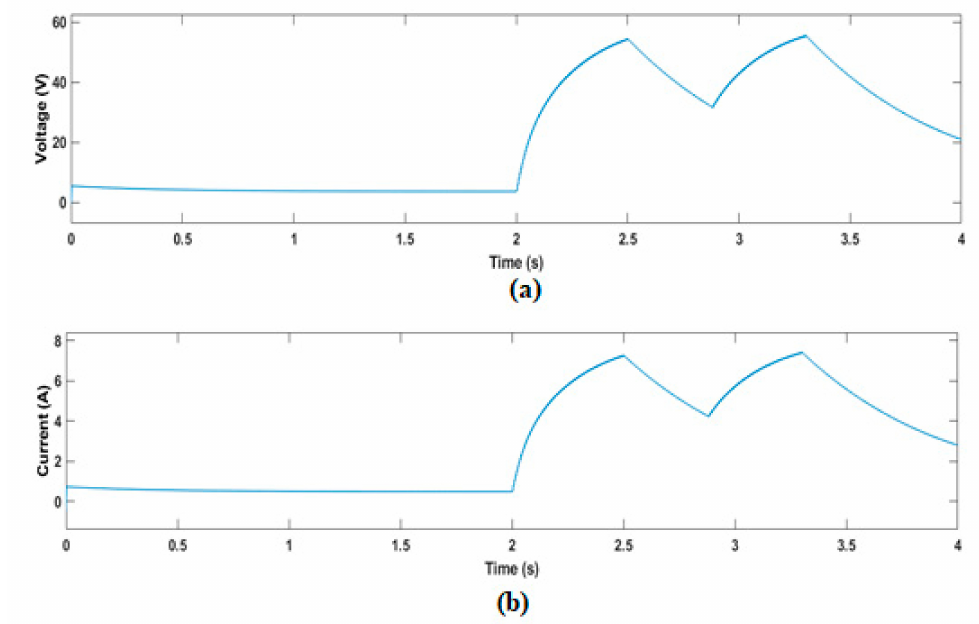
Figure 23. SEPIC converter outputs. ( a ) Voltage and ( b ) current for braking